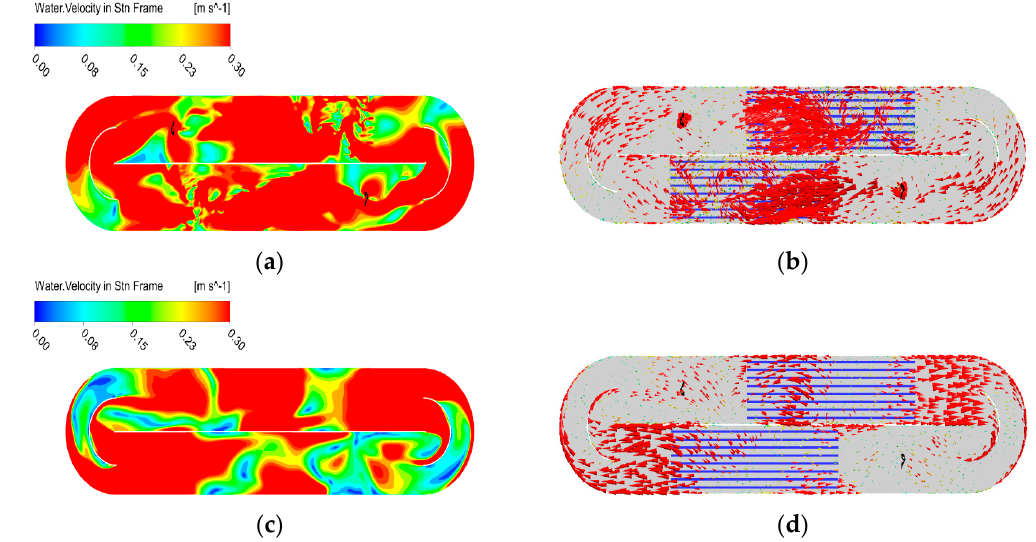
Figure 7. Water velocity contour ( a, c ) and water velocity vectors ( b, d ) on a horizontal plane at 0.5 m and 6 m (from top to bottom) above the tank floor.